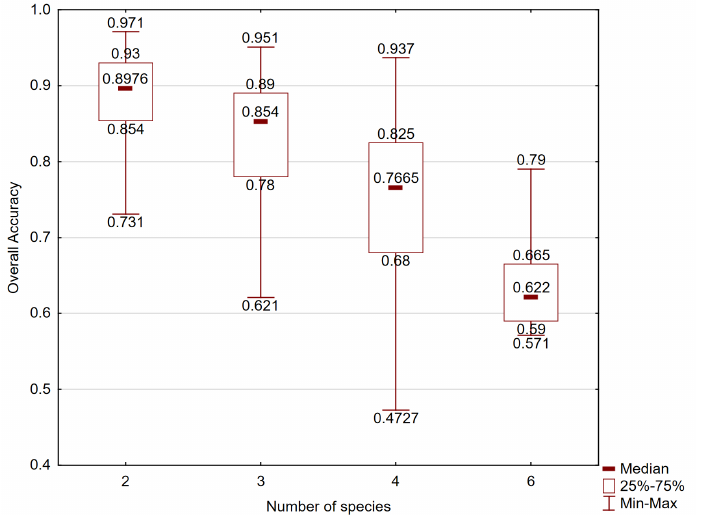
Figure 3. Relationship between the overall accuracy and number of discriminated species in the reviewed